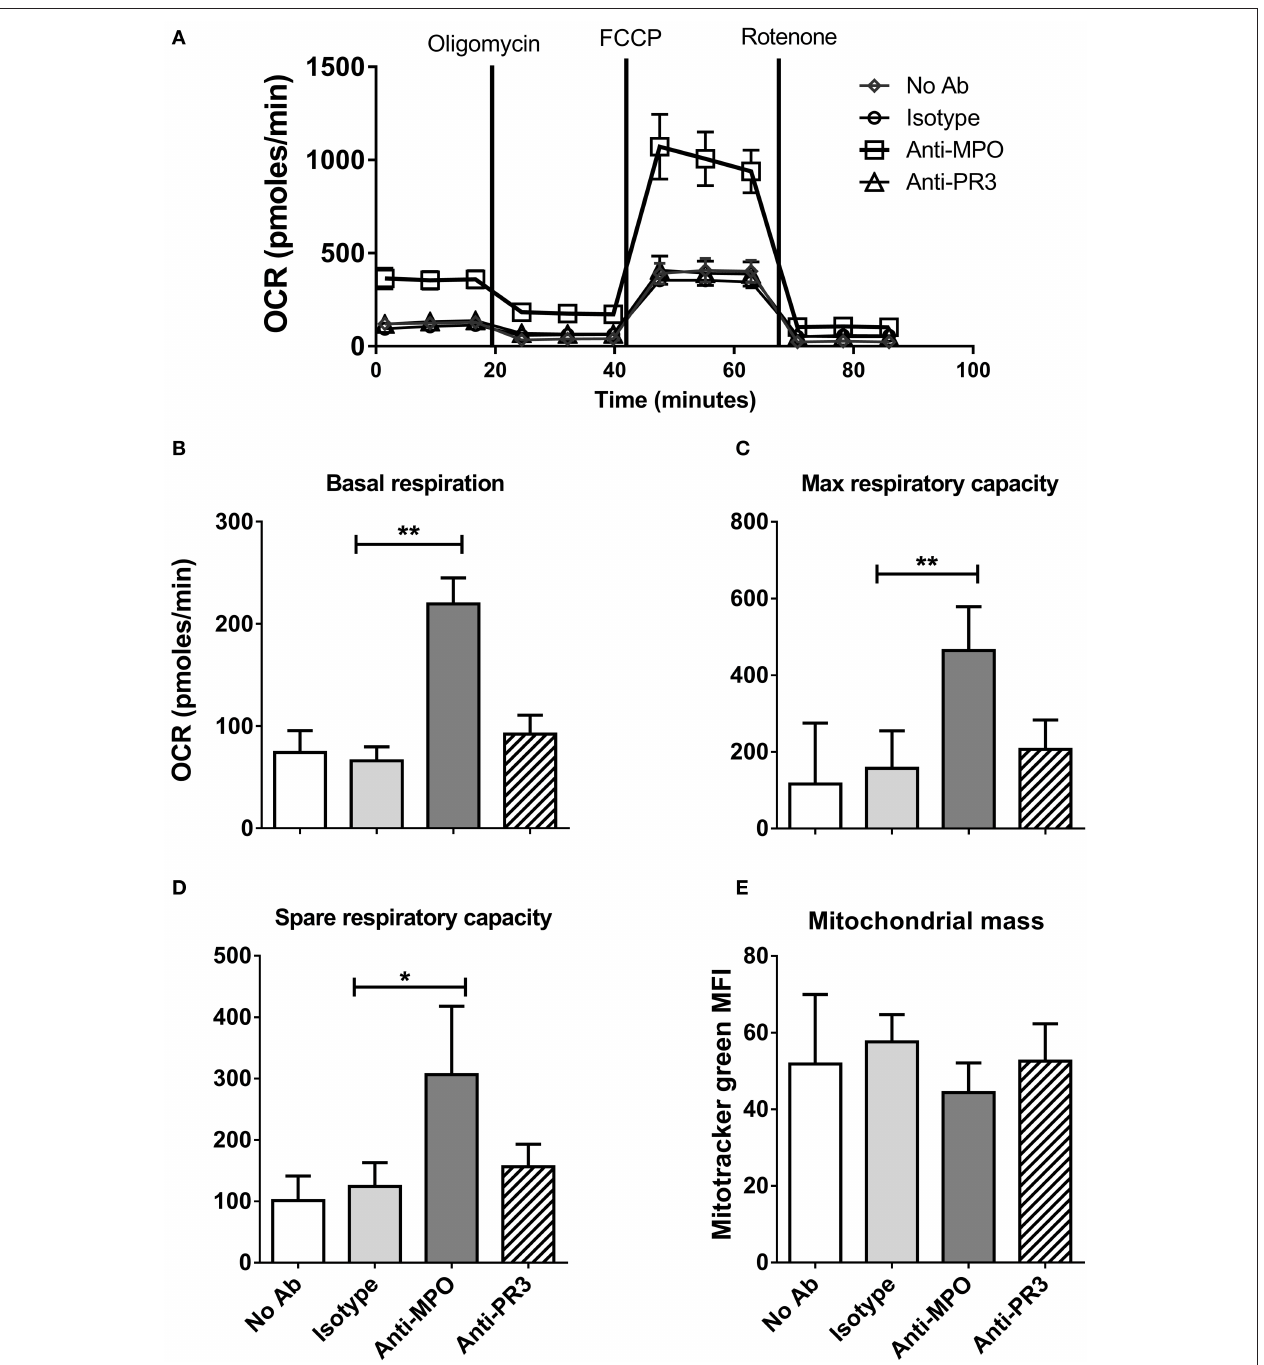
FIGURE 2 | Anti-MPO, but not anti-PR3 stimulation of monocytes leads to increased oxidative respiration and respiratory capacity. CD14 + monocytes were stimulated with 5 µ g/ml mAb directed against MPO, PR3 or isotype control antibody. Initial oxygen consumption rate (OCR) was measured followed by addition of 4 µ M oligomycin, 2 µ M FCCP and 4 µ M rotenone (A) . Basal respiration levels were calculated by subtracting the non-mitochondrial respiration (post rotenone addition) from the initial OCR readings (B) . Maximum respiratory capacity was calculated by subtracting non-mitochondrial respiration from OCR values following the addition of FCCP (C) . Spare respiratory capacity was calculated by subtracting basal from maximum respiration (D) . Mitochondrial mass was measured by flow cytometry of cells incubated with 50nM MitoTracker Green following stimulation as above (E) . Data are presented as the mean and SEM. Statistical analysis was performed by one-way ANOVA with Friedman’s post-test (* p < 0.05, ** p < 0.01) ( A–D n = 6, E n = 3).